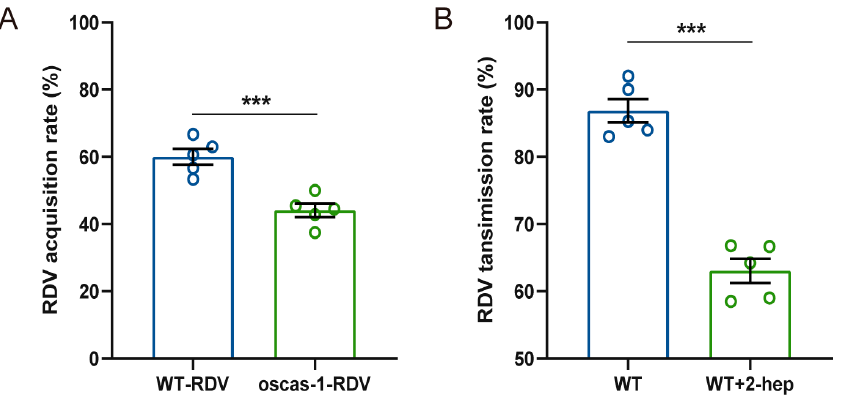
Figure 7. RDV acquisition and transmission rate by N. virescens : ( A ) RDV acquisition rate by non- viruliferous N. virescens between WT and WT-RDV rice plants, and between oscas1 and oscas1-RDV rice plants. ( B ) RDV transmission rate by viruliferous N. virescens between WT plants plus 10 µ L pure lanolin paste (WT) and WT plants plus synthetic 2-heptanol (2-hep, 8.17 μ g) in 10 μ L of lanolin (WT+2-hep). WT, wild type (Minghui63, MH63) (RDV-free); WT-RDV (MH63-RDV) (RDV-infected); oscas1, mutant rice plant (RDV-free); oscas1-RDV, mutant rice plant (RDV-infected). (*** p < 0.01, Student’s t-test). Data are mean ± standard error ( n = 5).